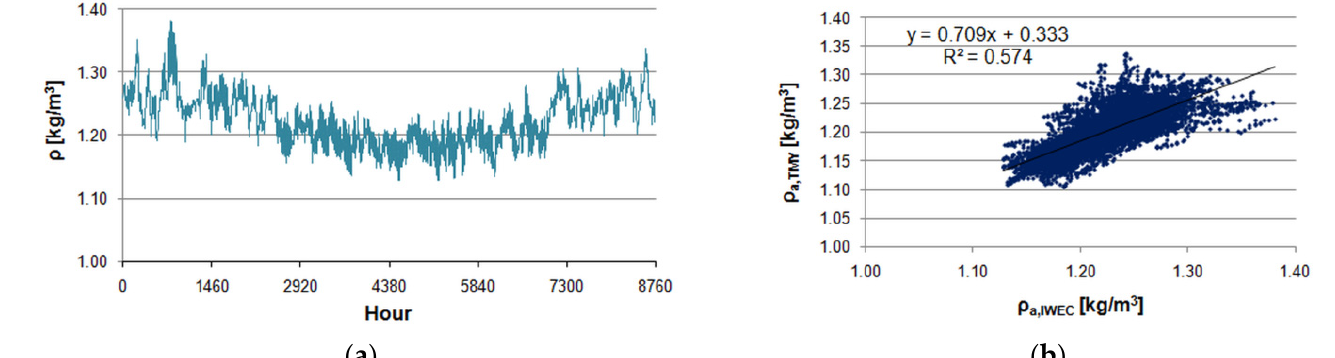
Figure 9. Hourly air density for Kraków calculated from the IWEC data: ( a ) during the year; ( b ) correlation of hourly values in relation to the results from EN 16798-5-1. Volumetric heat capacity for EN 16798 (method 1) amounted to 1182.43 J/(m 3 K). In the third method, the hourly value (dark green colour in Figure 10) was from 1111.58 J/(m 3 K) to 1344.93 J/(m 3 K) in comparison to the annual average of 1210.08 J/(m 3 K). Monthly averaged values were from 1167.95 J/(m 3 K) in June to 1257.87 J/(m 3 K) in February.